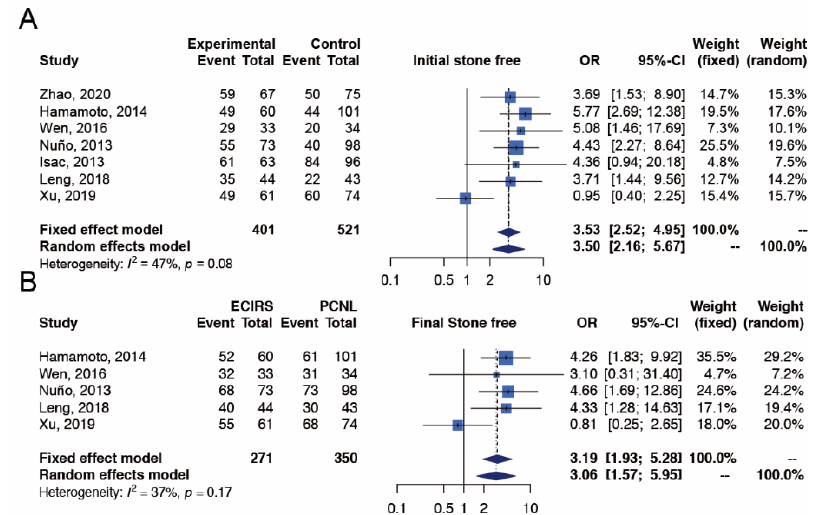
Figure 2. Meta-analysis of efficacy outcomes, including ( A ) initial stone free rate [17–23] and ( B ) final stone free rate [17,19,20,22,23] between ECIRS and PCNL groups.